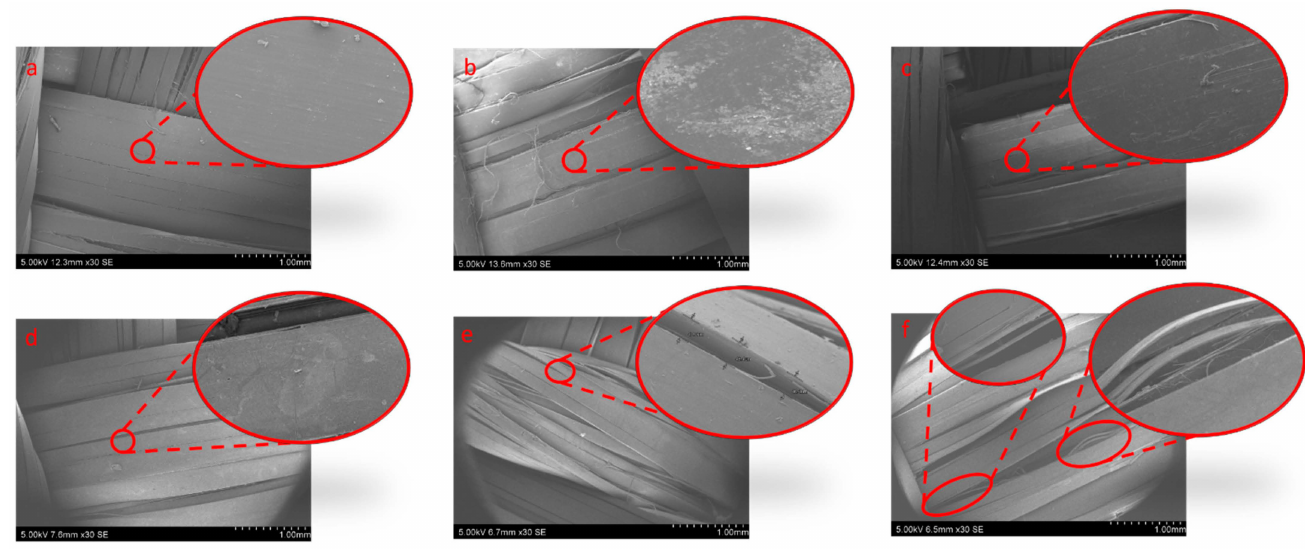
Figure 6. SEM micrographs of woven fabrics at ( a ) Month 1, ( b ) Month 2, ( c ) Month 3, ( d ) Month 4, ( e ) Month 5, and ( f ) Month 6 of